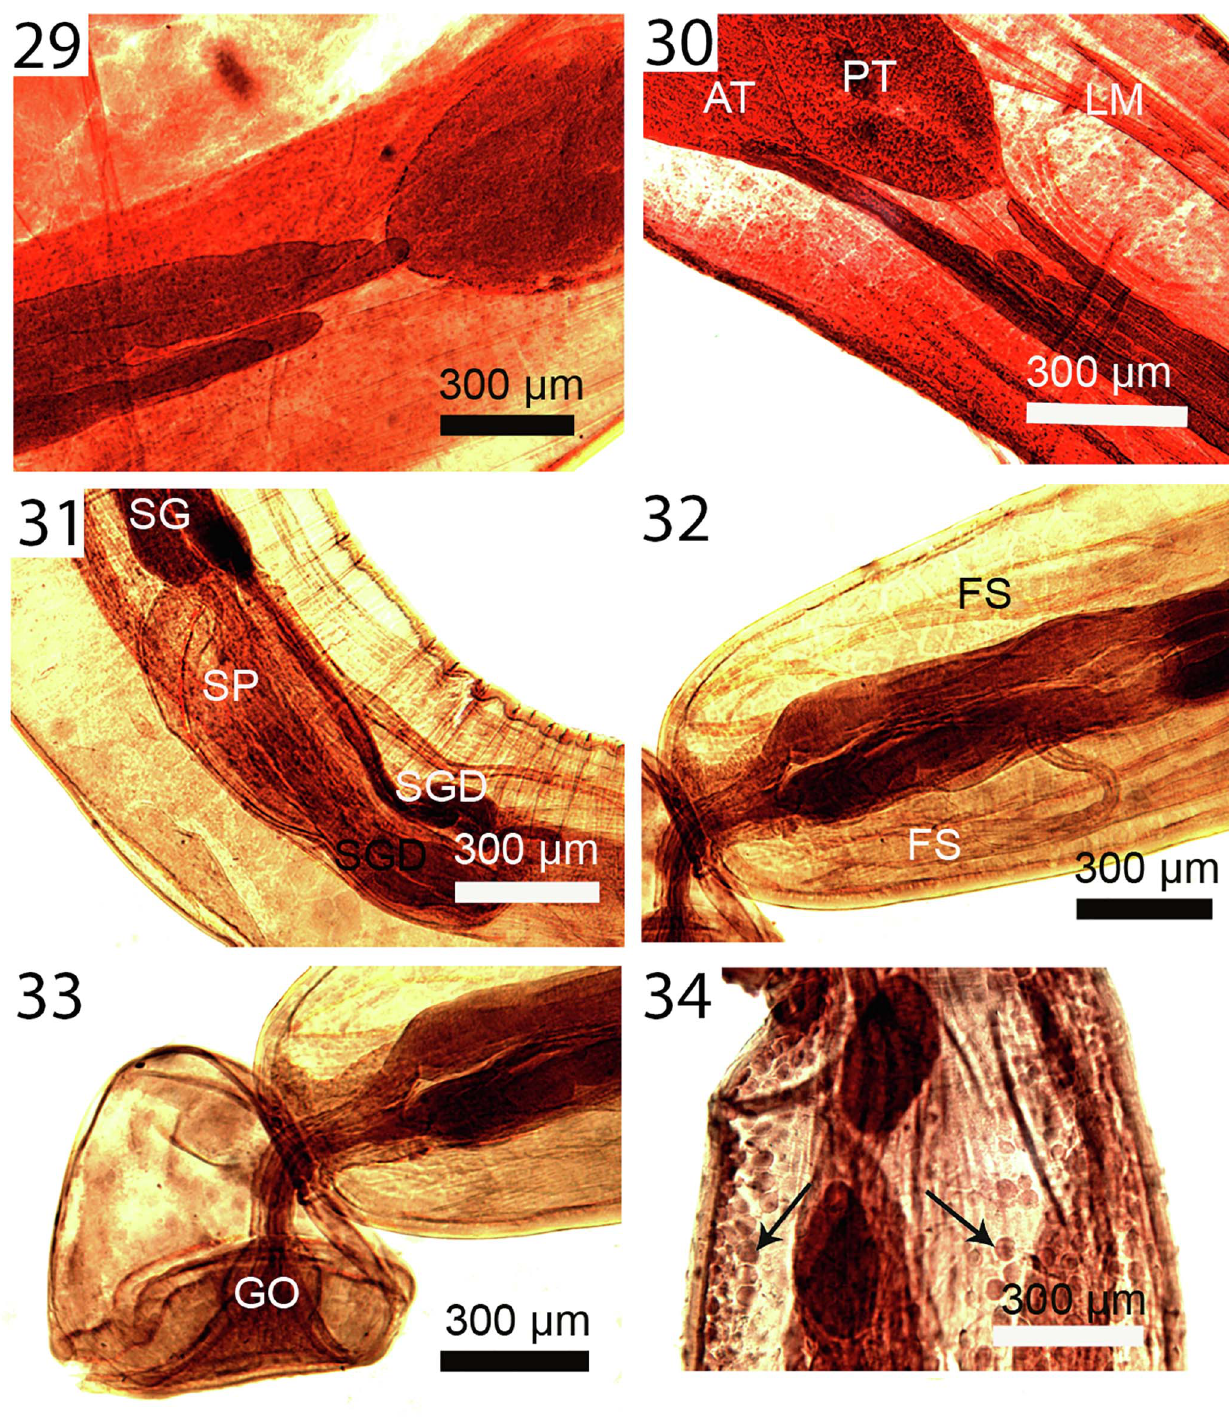
Figures 29 – 34. Micrographs of adult males of Pro fi licollis altmani from Larus belcheri (Figs. 29 – 33) and male cystacanth (Fig. 34) from Emerita analoga on the Peruvian coastline, Lima. 29. Anterior end of the 4 tubular cement glands interfacing with the posterior testis. Note that the unequal cement glands do not extend equally anteriorly. 30. Another example of extreme unequal anterior extension of cement glands to mid-point of posterior testis (PT) reaching anterior testis (AT). Note prominent longitudinal trunk muscles (LM). 31. Posterior part of a male reproductive system showing posterior end of cement glands (CG), cement gland duct (CGD), and Saefftigen ’ s pouch (SP). 32. A pre-bursal perspective showing independent cement glands ’ ducts and associated fi bral strands (FS). 33. The bell-shaped bursa with the cement gland ’ s ducts channeling into the genital ori fi ce (GO). No sensory structures were observed. 34. Developing testes in a cystacanth posterior to the second body constriction. Note the early stages of the hypodermic cells (arrows) throughout that are more developed in adults in Figure